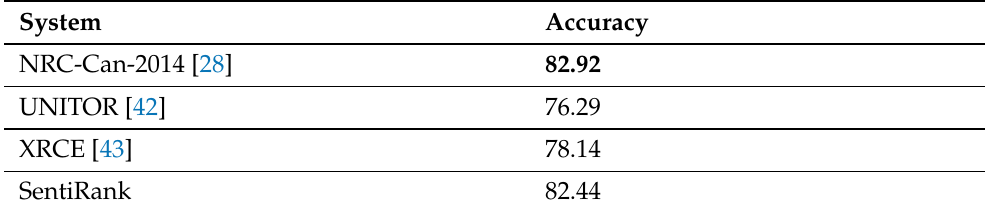
Table 6. Evaluation of the polarity calculation